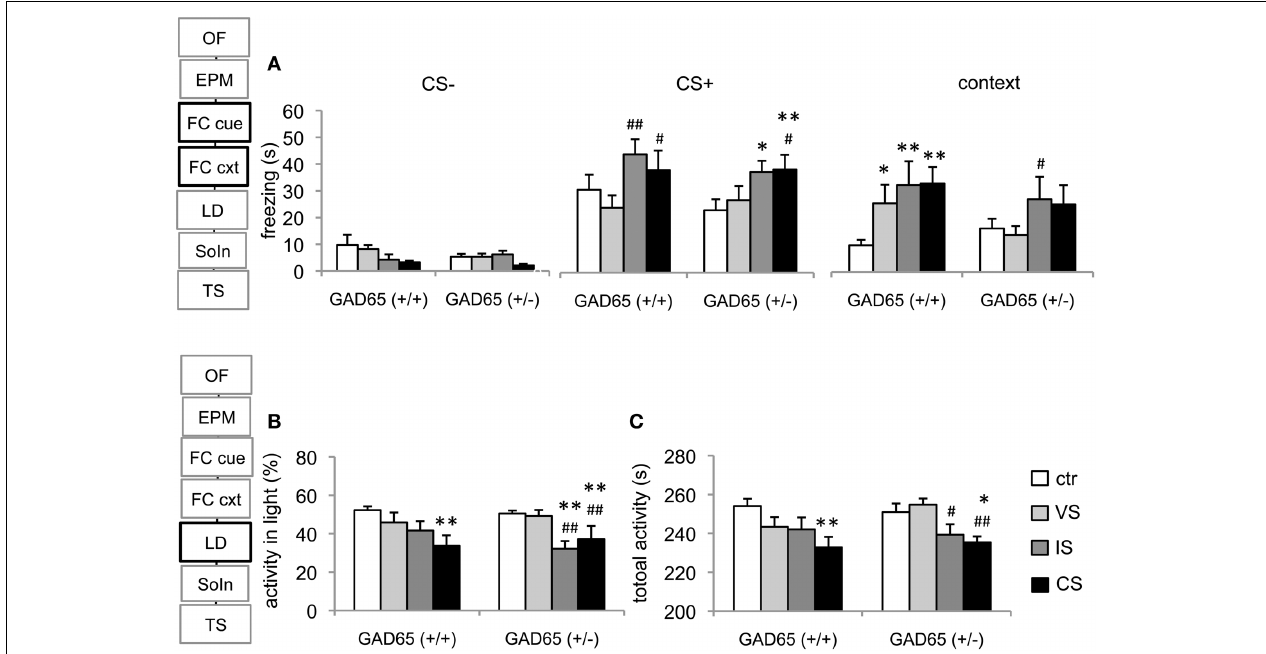
FIGURE 2 | Conditioned fear and light-dark avoidance test. (A) Cued fear memory did not generalize to a neutral tone (CS − ) in response to stress experience or genotype. Social isolation increased freezing to the conditioned tone (CS + ) in both genotypes, reaching statistical significance when wild type IS and CS mice were compared to VS mice. IS and CS heterozygous mice differed significantly from the ctr-group and the CS-group also differed from VS mice. In GAD65( + / + ) mice all three stress protocols lead to contextual fear generalization. In contrast, only the IS-group differed from the VS-group in GAD65( + / − ) mice. (B) In GAD65 wild type mice the three stress protocols